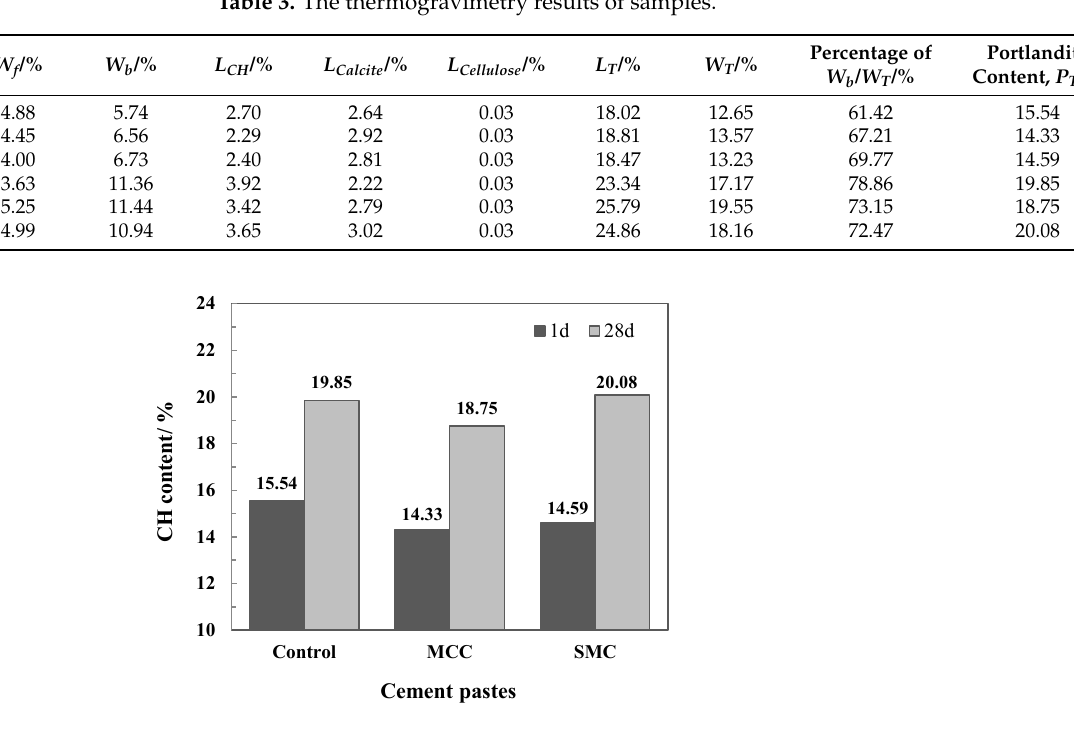
Table 3. The thermogravimetry results of samples.